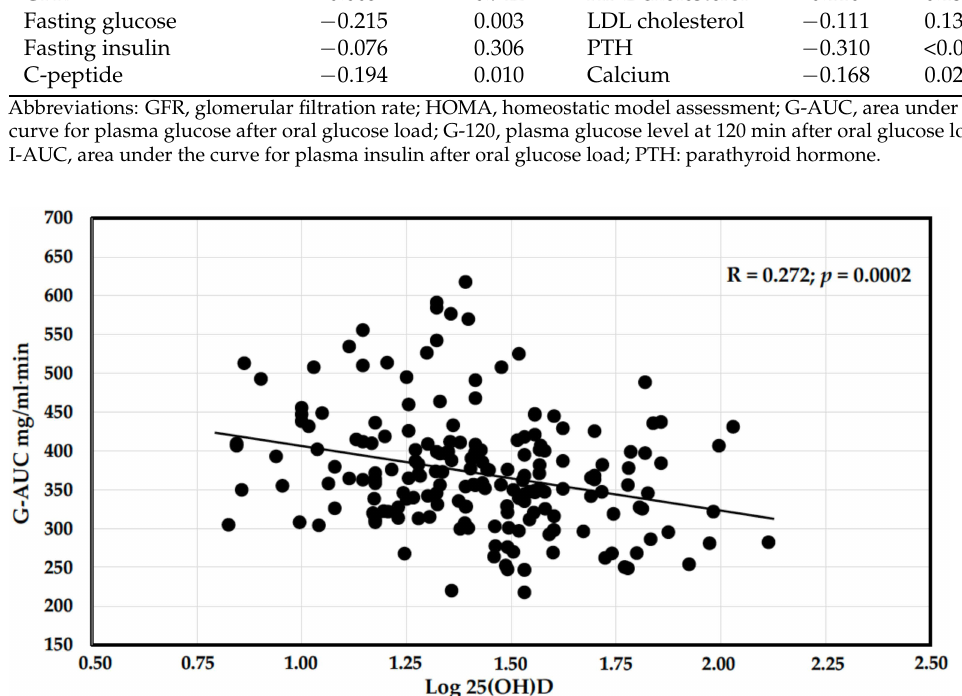
Figure 2. Correlation graph of log 25(OH)D and G-AUC. In nondiabetic hypertensive patients, a highly significant inverse correlation was observed between log transformed serum vitamin D levels and the plasma glucose response curve after an oral glucose tolerance